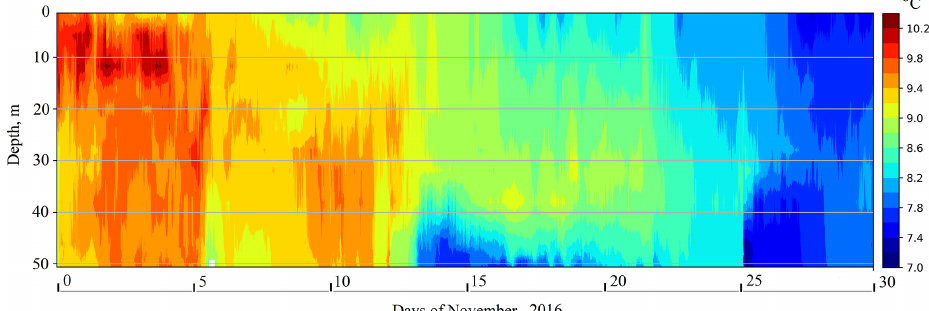
Figure 16. Water temperature variability in the Jyrgalan canyon in November 2016, as obtained from thermistor chain